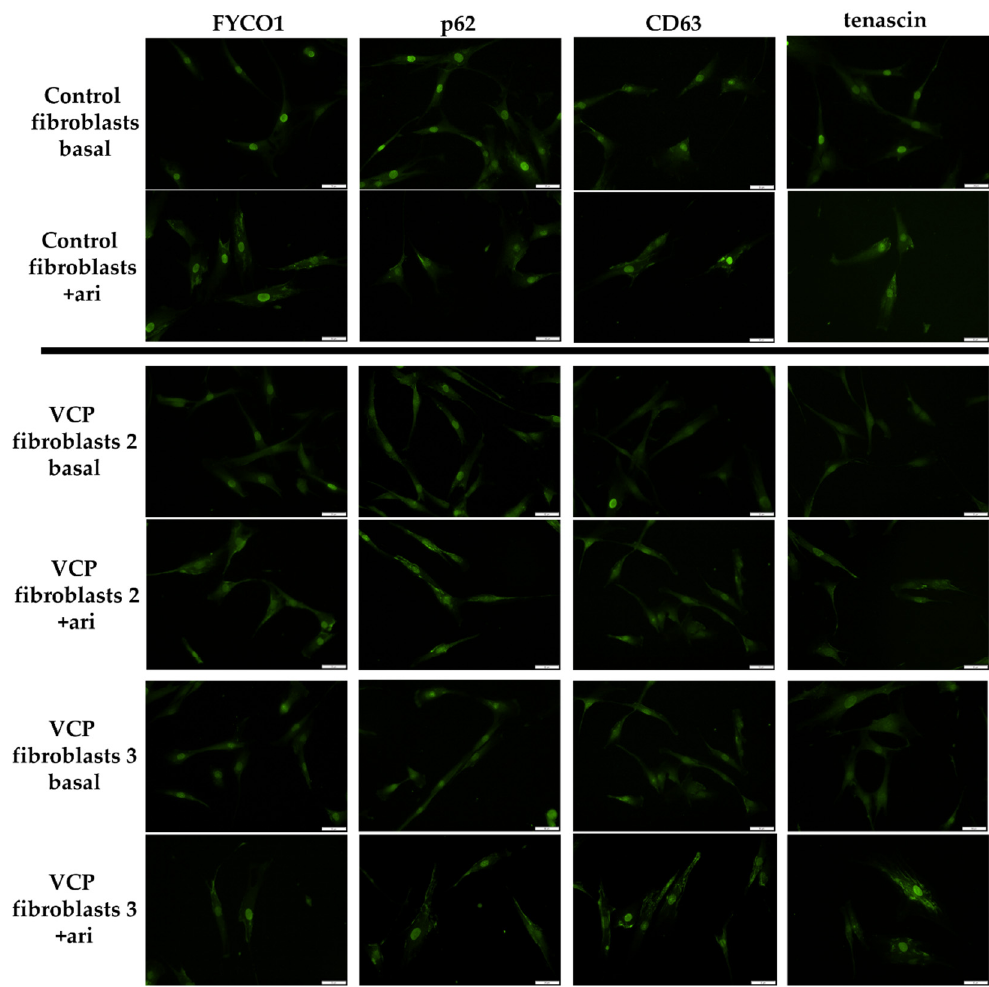
Figure 5. Immunofluorescence studies on VCP –mutant and control fibroblasts at basal conditions and after arimoclomol (ari) treatment. Arimoclomol treatment resulted in cytoplasmic increase of FYCO1, which is more pronounced in controls (control 1 is shown as one representative control). Decrease of p62–immunoreactivity within the nuclei of control fibroblasts treated with arimoclomol and p62 enrichment within the cytoplasm of VCP –mutant fibroblasts. CD63 showed an increased cytoplasmic immunoreactivity in both control and patient derived fibroblasts after arimoclomol treatment. A similar finding was obtained for tenascin. Scale bars = 50 µm. Two representative patients are shown: VCP fibroblasts 2 = patient 2 and VCP fibroblasts 3 = patient 3; patient numbering is consistent with patient numbering in Figure 1.